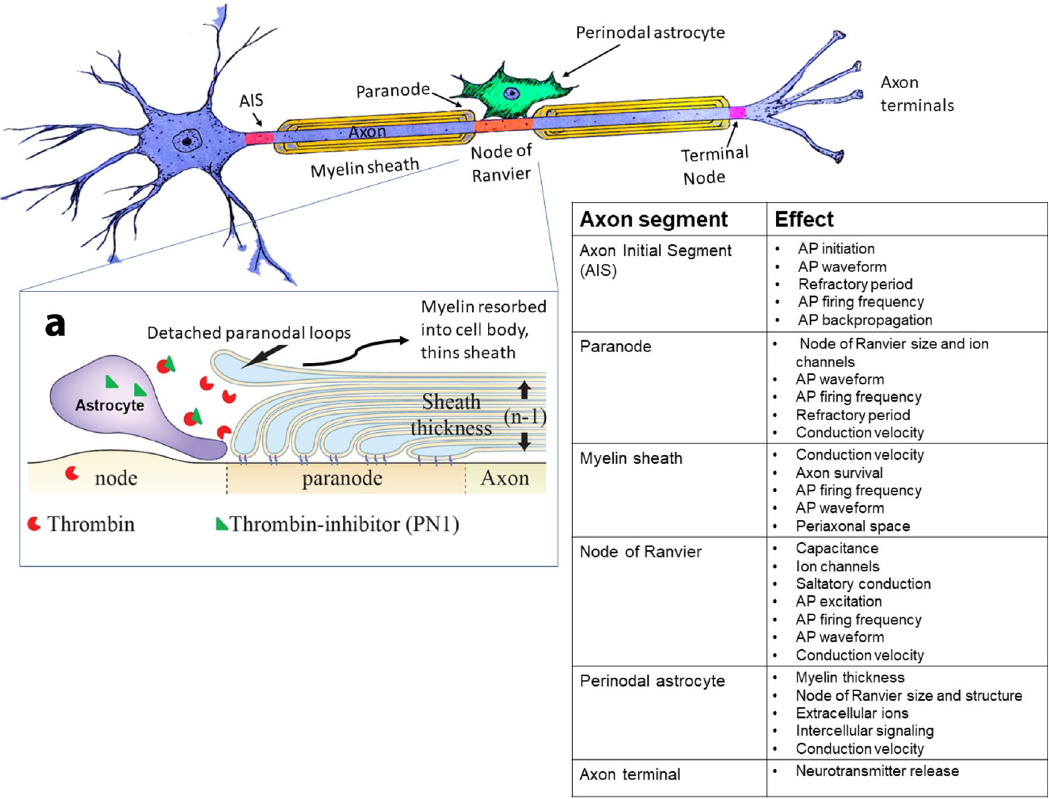
Fig. 3 Cellular mechanism of oligodendroglial involvement in memory storage. Encoding and storage of information in learning are in fl uenced by oligodendroglial involvement in many aspects of action potential fi ring and propagation. In addition to altering conduction velocity through activity- dependent myelination and plasticity of the myelin sheath, activity-dependent effects on the axon initial segment, nodes of Ranvier, axon terminals, and interactions with perinodal astrocytes will determine action potential activation, fi ring frequency, refractory period, and other aspects of neuronal excitation that will participate in information encoding and storage in non-associative and associative learning. a Shows widening of the nodal gap in mature myelin to reduce conduction velocity by lifting of the paranodal loops of myelin. This mechanism of widening the nodal gap and thinning the myelin sheath is under control of the perinodal astrocytes by releasing protease inhibitors (green) to inhibit thrombin (red) cleavage of the cell adhesion molecules attaching myelin to the axon. Modi fi ed from Fields and Dutta (2019) 96 , with